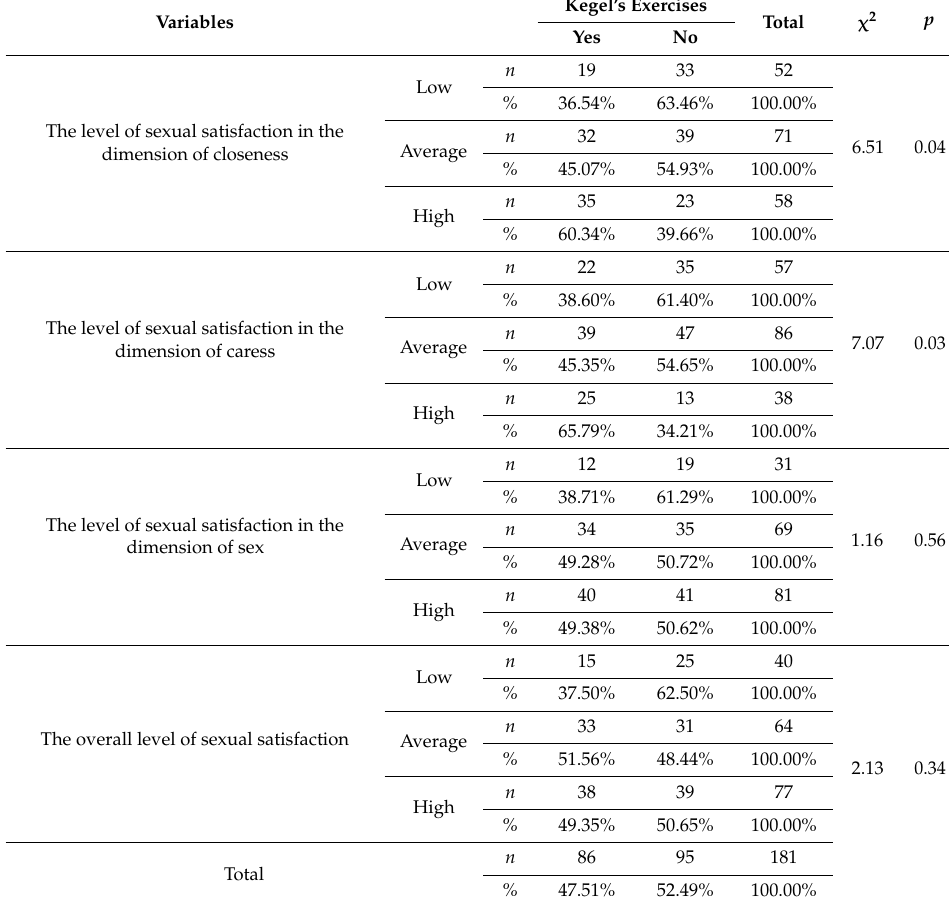
Table 13. Relationship between pelvic floor muscle exercises and the women’s sexual satisfaction.